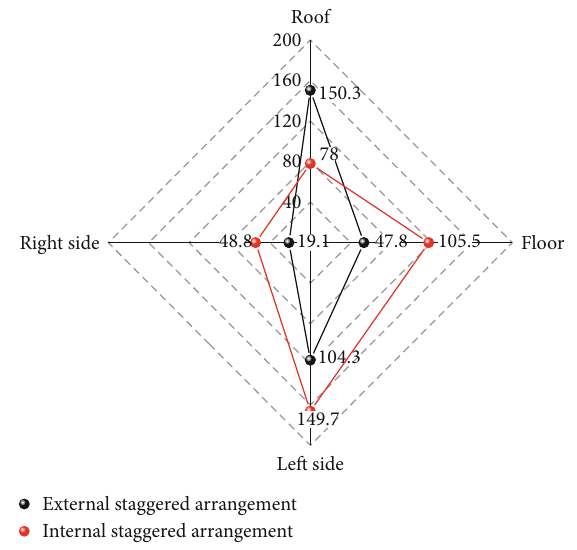
Figure 22: Deformation of surrounding rock of roadway with di ff erent